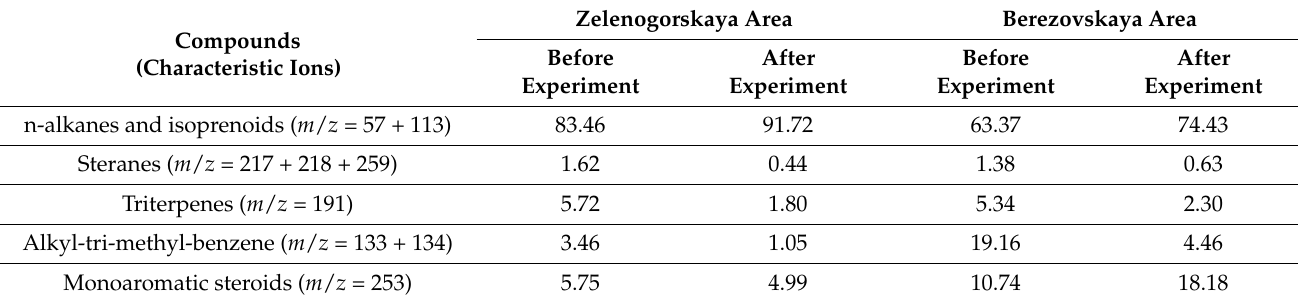
After Before After Experiment Experiment Experiment Experiment